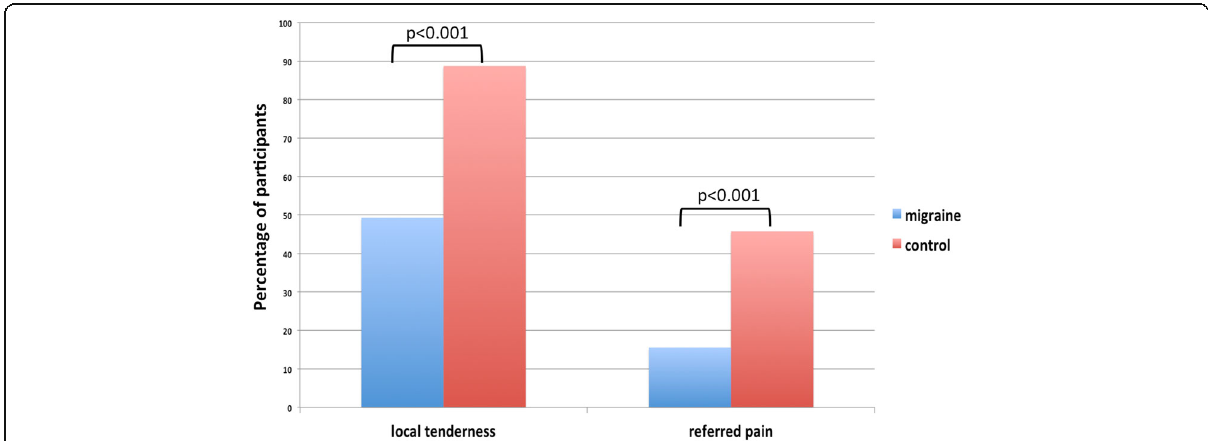
Fig. 2 Percentages of local and referred pain for migraine patients and